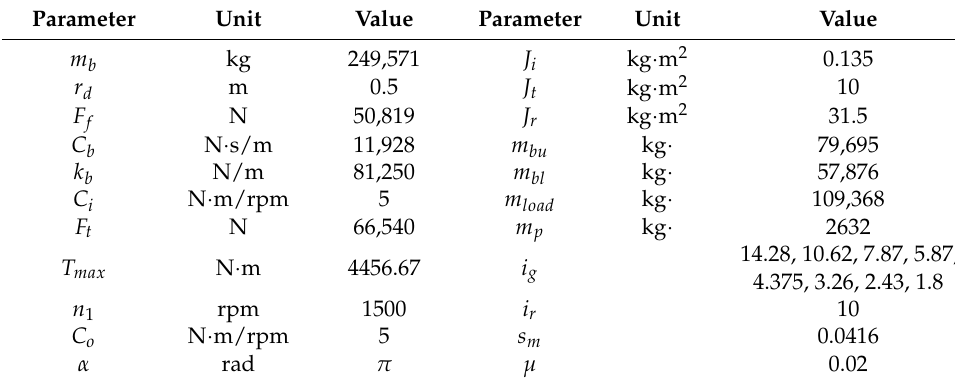
Table 2. Main parameters of the AMT soft-starting